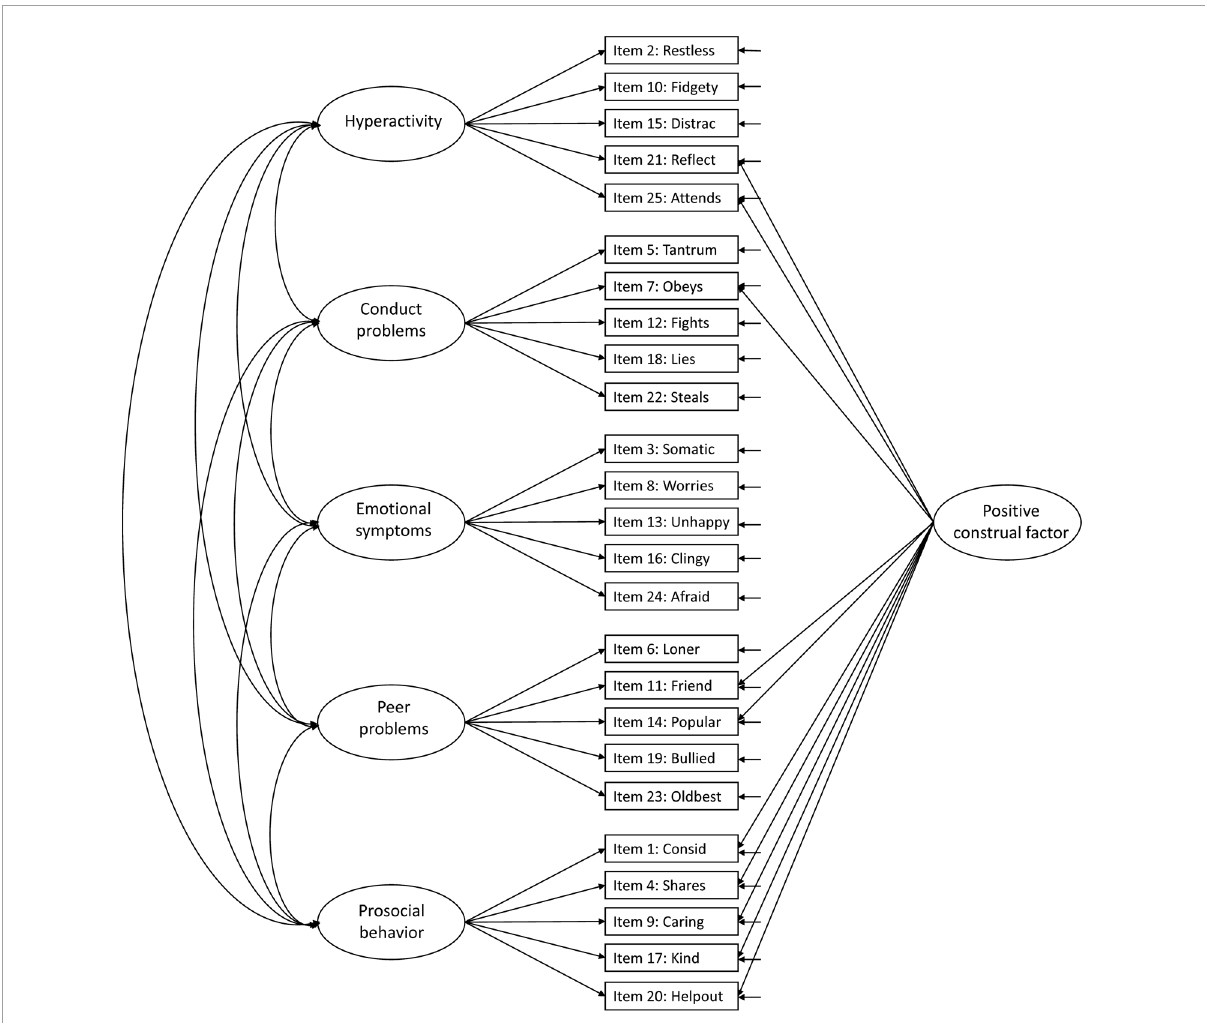
FIGURE4 Original five-factor structure with a positive construal method factor for the positively worded items (Model 4).